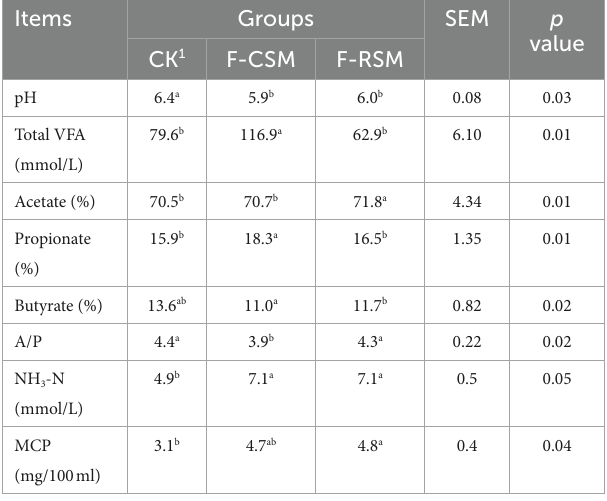
TABLE 3 Effects of the diets on ruminal fermentation parameters of Hu sheep. Items